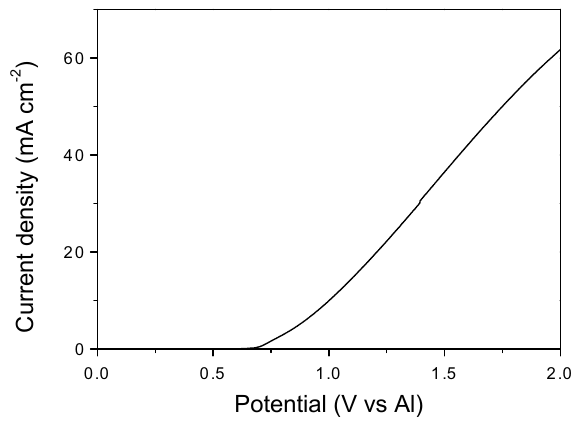
Fig. 1: Figure 1. Anodic polarization curve for Ti substrate in DMSO 2 -AlCl 3 bath at 110 °C.